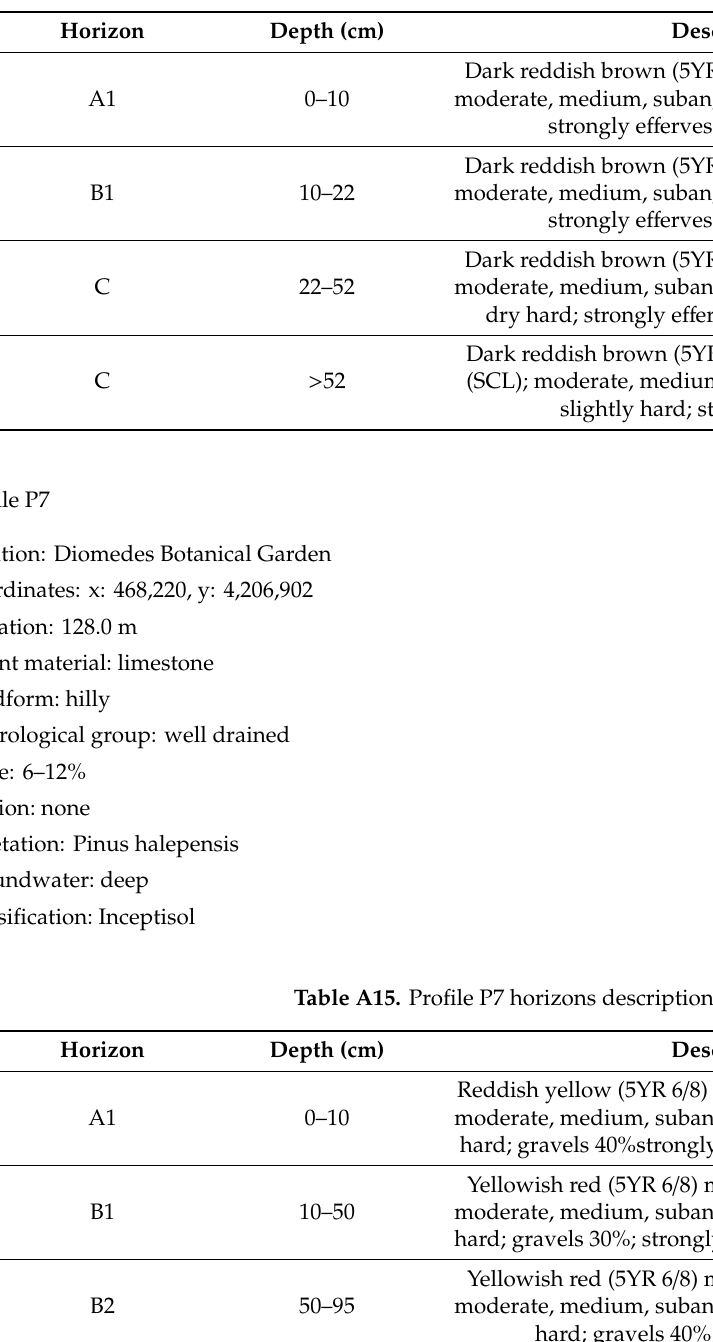
Table A14. Profile P5 horizons description.